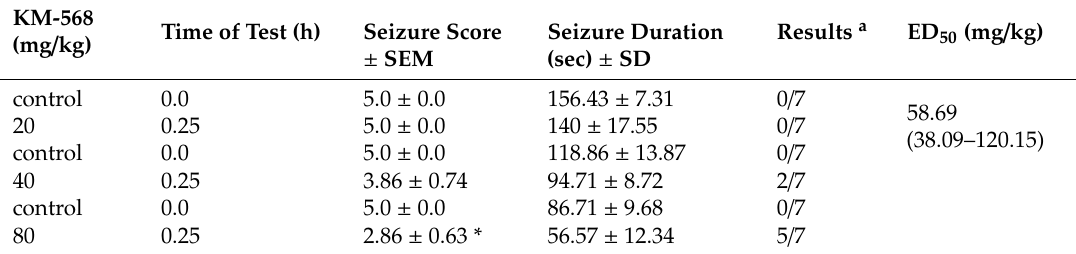
Table 8. Results of lamotrigine-resistant amygdala kindled rat model after 0.25 h of intraperitoneal administration of compound